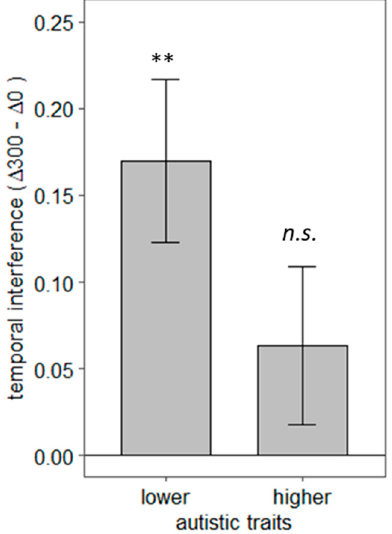
Figure 5. Link between autistic traits and sensitivity to temporal deviations in observed social interactions. Y-axis shows the mean temporal interference index that corresponds to the difference between LISAS at ∆ 300 and ∆ 0. Positive values that significantly differ from zero indicate sensitivity to temporal deviations. Participants were split into higher and lower autistic trait groups according to their autism quotient score, shown in the x-axis. Error bars represent +/ − one standard error of the mean; n.s. indicates a non-significant comparison; ** indicates a comparison with p <